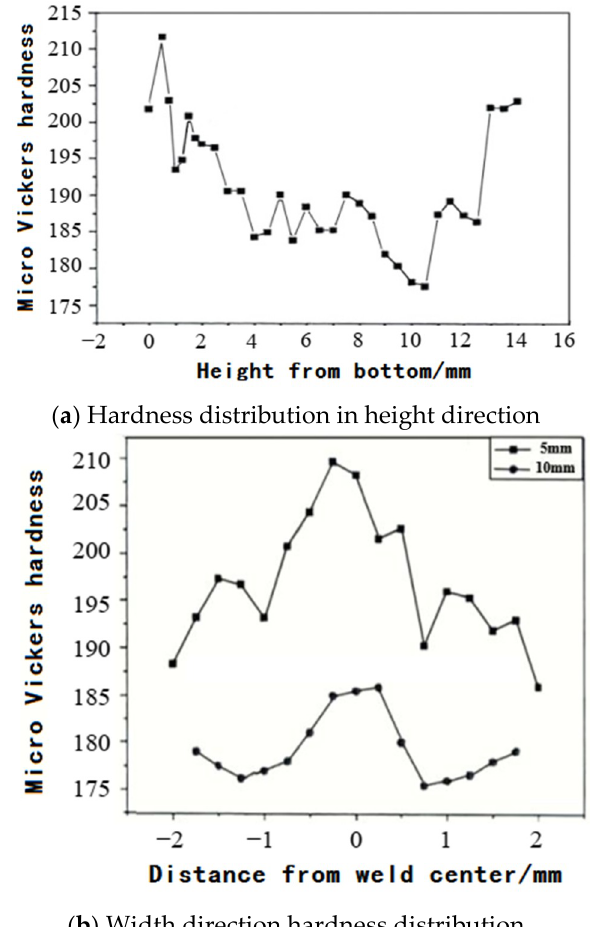
Figure 6. Hardness distribution diagram.